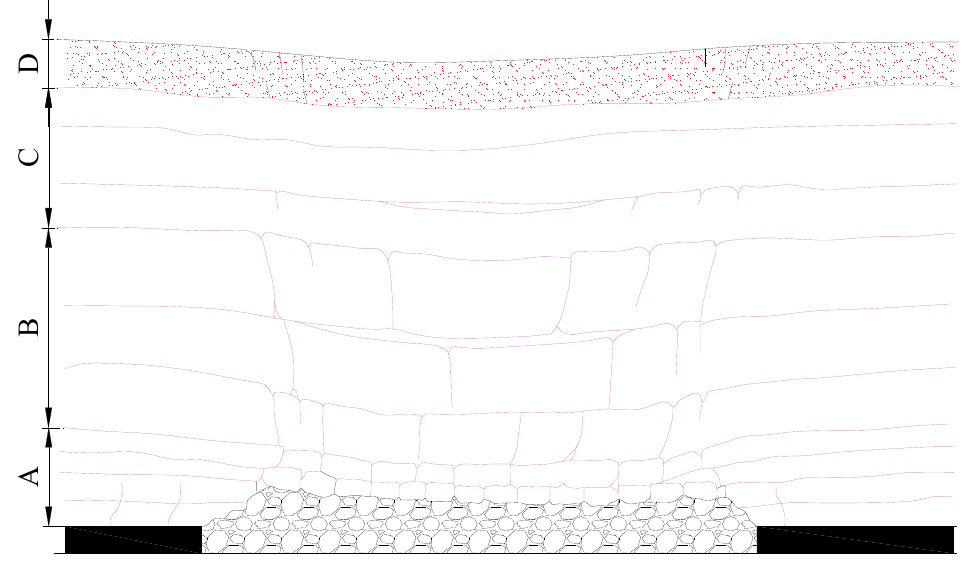
Figure 1. Four zone of strata movement above a longwall panel.